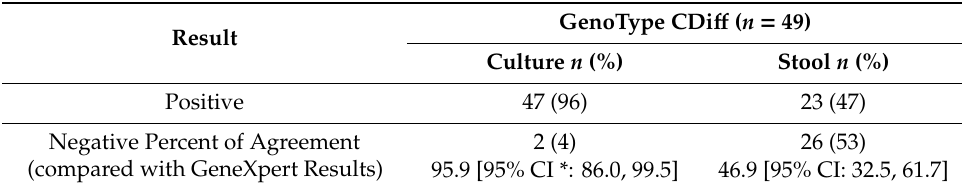
Table 1. Comparison between identification of C. di ffi cile by GenoType CDi ff from stool samples vs. culture samples.